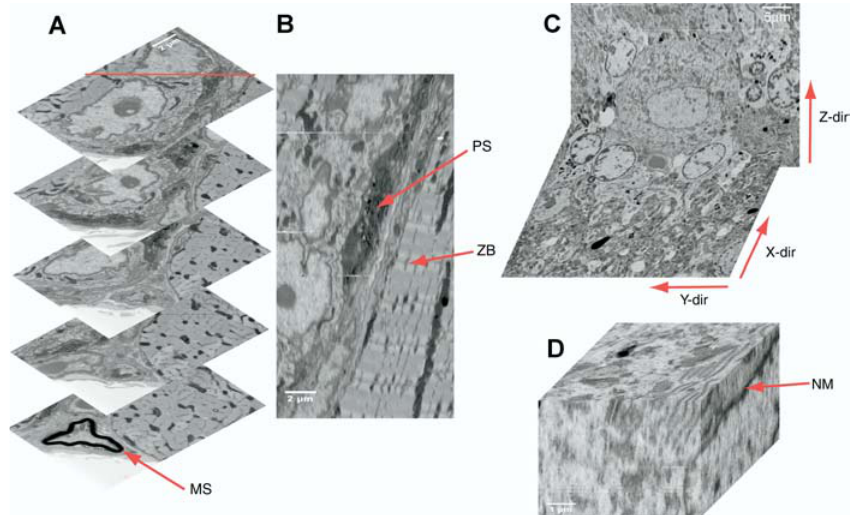
Figure 3. 3D Datasets: Five Slices (A) Five slices from a stack containing a total of 365 slices at 63-nm section thickness; same tissue as in Figure 1A and 1B. Note beginning of myelin sheath (MS) in the lowest slice. Imaging con- ditions as in Figures 1A and 1B except resolution is 13.4 nm/pixel. (B) Reslice of the same dataset along the red line show in the top image of (A). Arrows point to the presynaptic ending (PS) and the z-band (ZB). Image corners in (A) touch the reslice (B) at the depths at which they were taken. (C and D) Cerebellar tissue displayed at low (C) and high (D) resolution; note nuclear envelope (NM). Note differences in lateral and vertical resolution. Imag- ing conditions for (C) and (D): electron energy, 7.5 keV; spot size, 3.5; digital resolution, 12.7 nm/pixel. DOI: